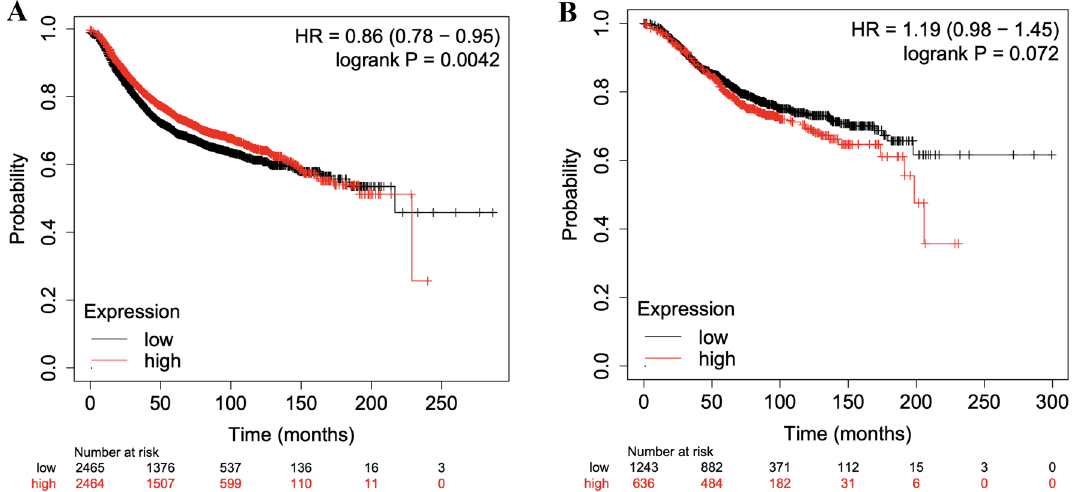
Figure 6. Kaplan–Meier plots of ( A ) recurrence-free survival in patients and ( B ) overall survival with ‘high’ and ‘low’ RHOD expression in overall breast cancer.